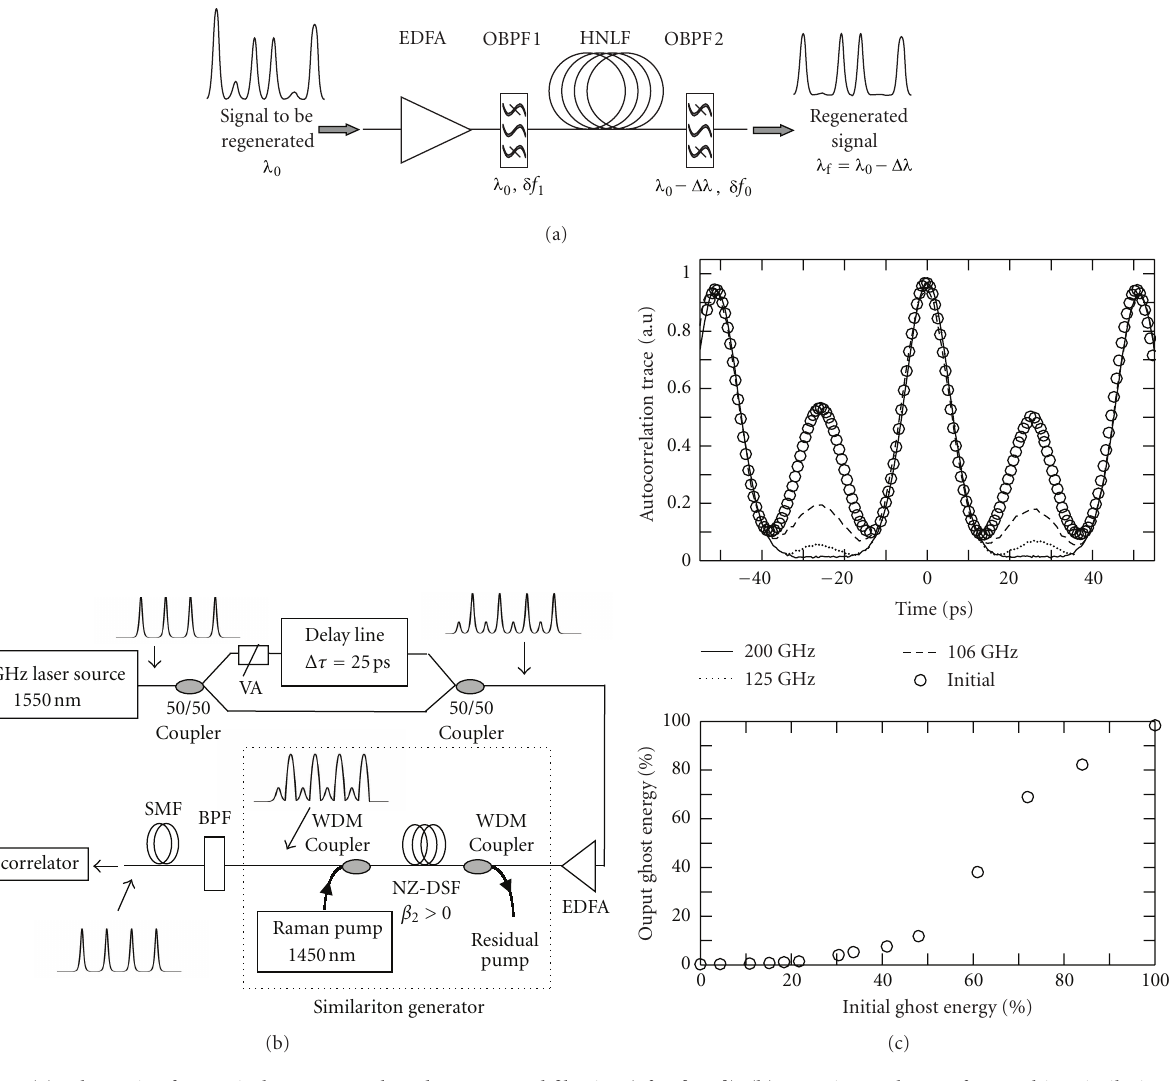
Figure 5: (a) Schematic of an optical regenerator based on SPM and filtering (after [100]). (b) Experimental setup for 40Gbit/s similariton- based regeneration. (c) Top, autocorrelation traces of the pulse train at the Raman amplifier input (circles) and output for di ff erent values of the filter o ff set (dashed, dotted, and solid curves). Bottom, output versus input proportion of the spurious noise pulse energy with respect to the ones energy for a fixed filter o ff set. Results adapted from